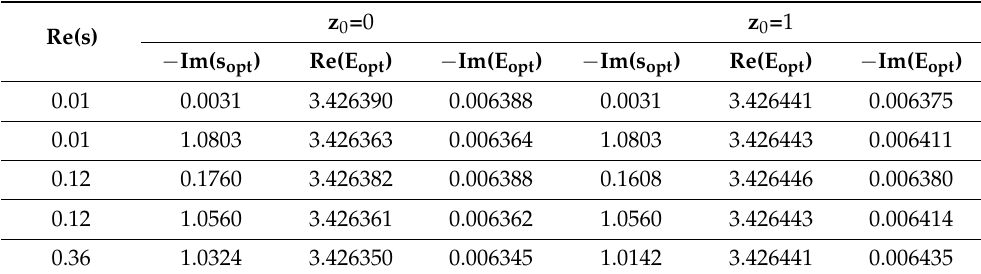
Table 1. Optimal trajectory points (problem I). All the data are presented in a.u. z 0 = 0 z 0 = 1 Re(s) − Im(s opt ) Re(E opt ) − Im(E opt ) − Im(s opt ) Re(E opt ) − Im(E opt )